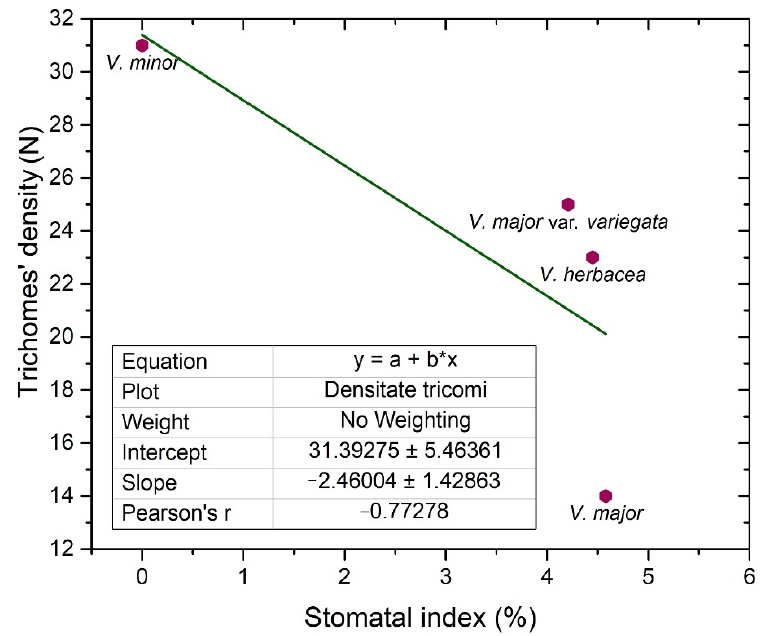
Figure 4. Linear fit of the trichomes’ density and stomatal index on the adaxial side of the examined Vinca leaves.